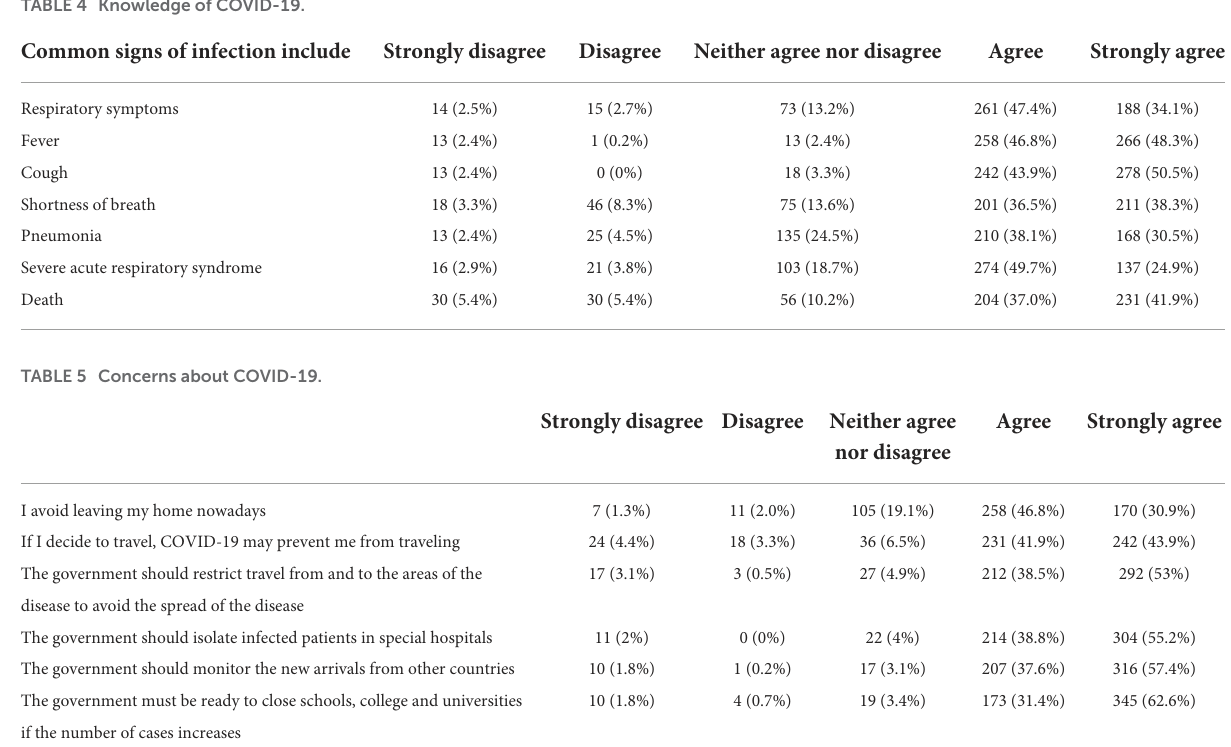
TABLE 4 Knowledge of